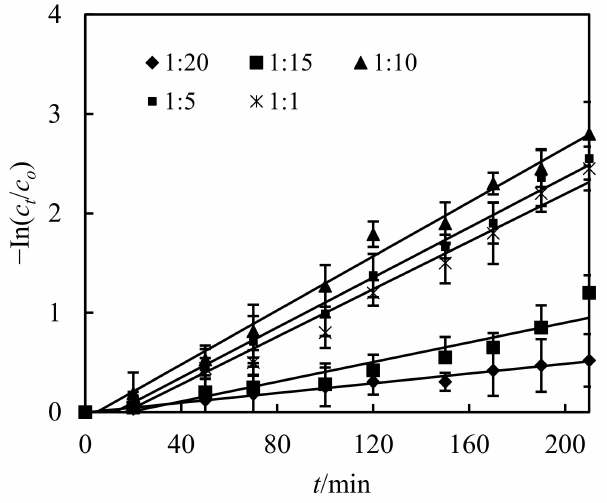
Figure 5. Impact of volumetric ratio of sheeting liquor and feeding liquor on dislodging of